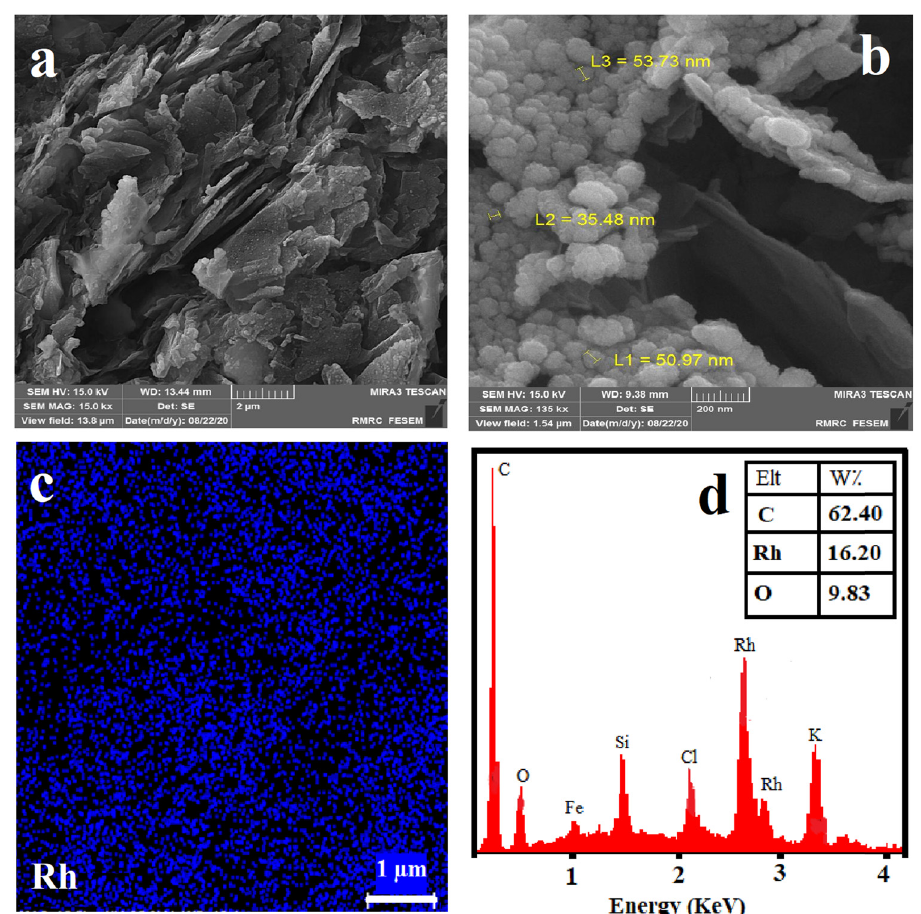
Figure 4: ( a ) and ( b ) FE - SEM images Rh - NPs/rGONs/graphite electrode with nanometer sized, ( c ) EDS mapping analysis of rhodium ( Rh ) element on the rGON - modi fi ed graphite electrode, and ( d ) EDS elemental analysis obtained from Rh - NPs/rGONs/graphite